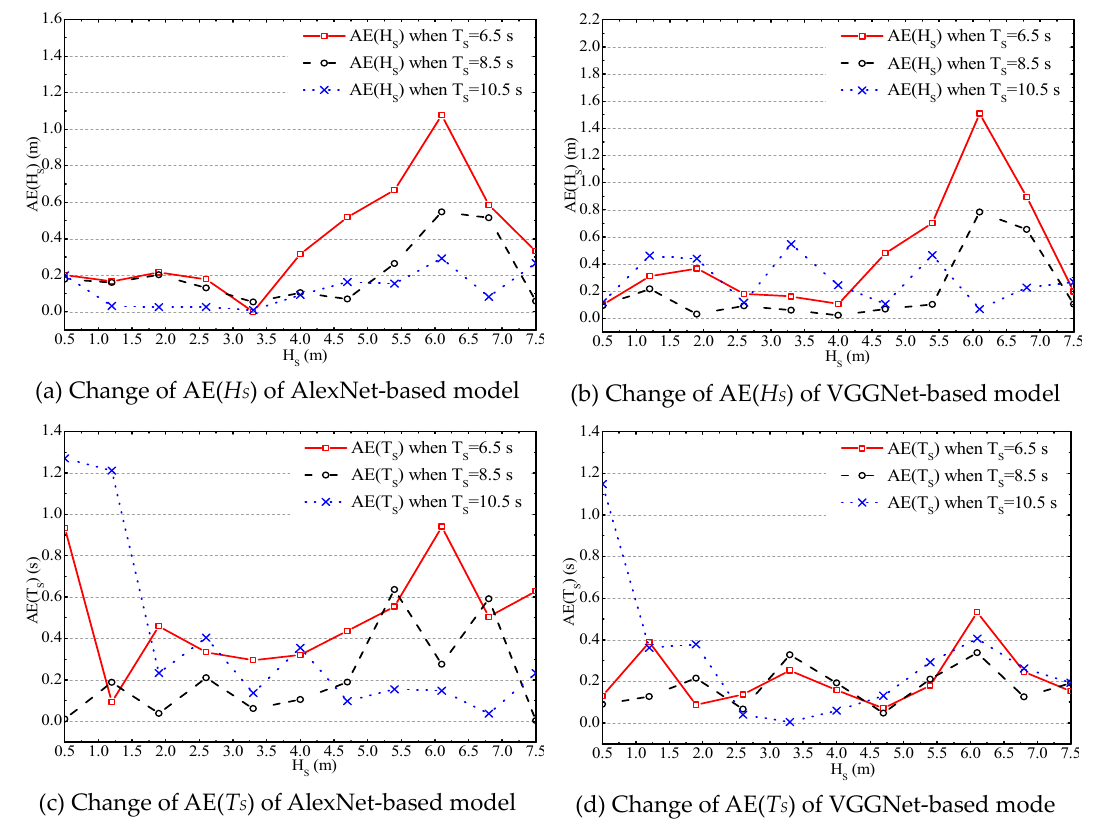
Figure 15. Change of AE with H S for different T S.